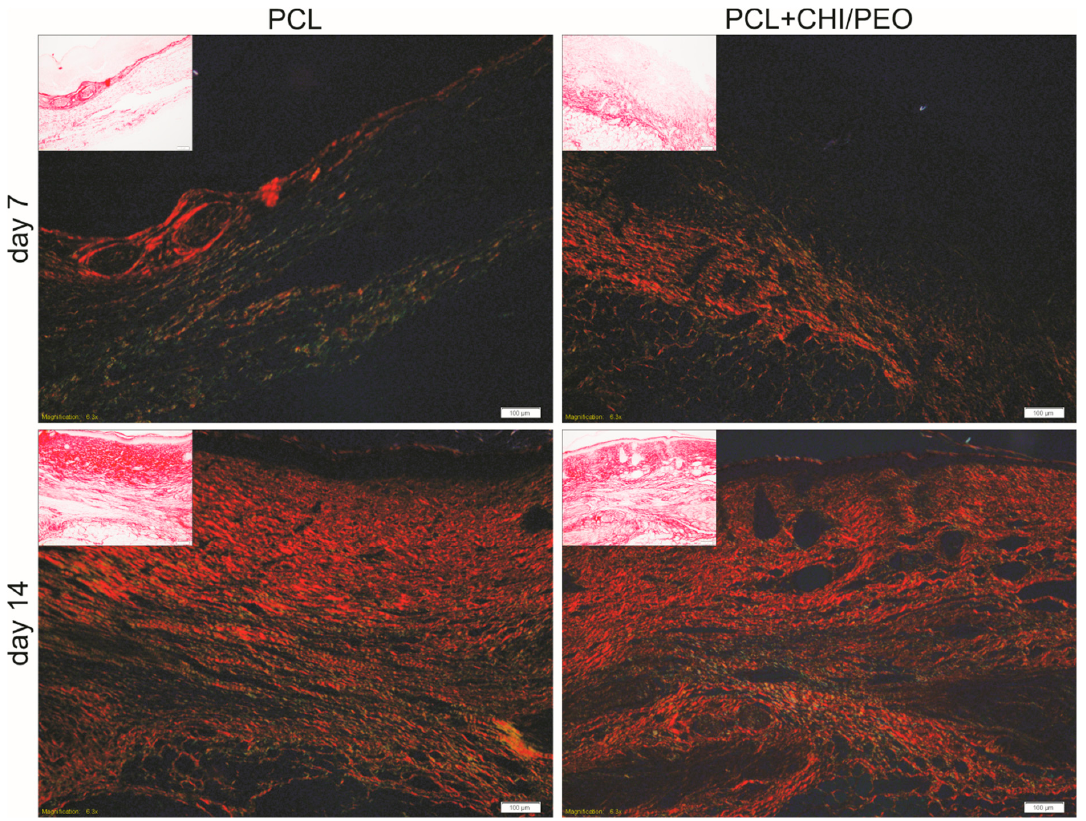
Figure 5. Collagen reorganization and representative results in the skin wound tissue of mice in 7 and 14 days. Collagen fibers from the region of mice excisional lesions treated with PCL or PCL+CHI/PEO membrane on the 7th and 14th experimental day with Sirius Red staining under polarized light and without polarized light (inserts). Objective: 10×.